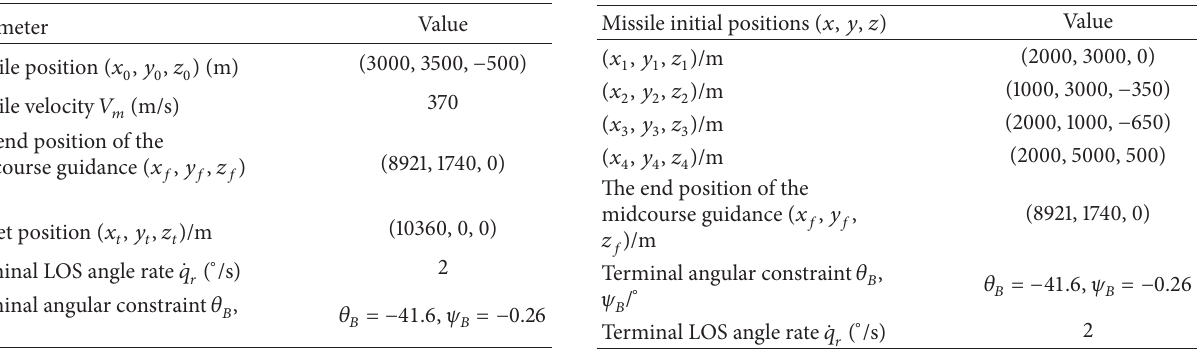
Table 8: Conditions for the simulations (NSMG and BPN). Table 9: Simulation of the different